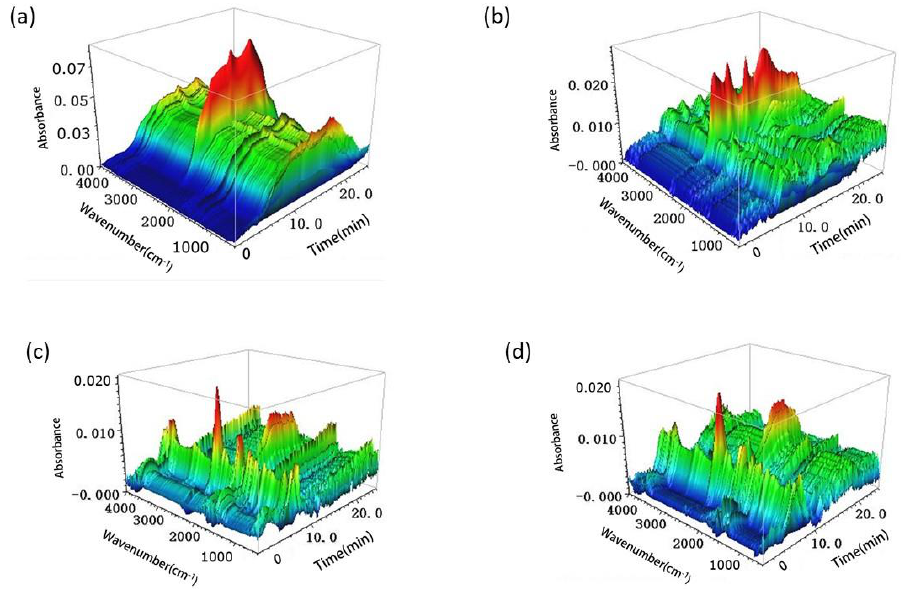
Figure 3. 3D FTIR spectrograms of bark ( a ), bark/Ag ( b ), bark/Co 3 O 4 ( c ), and bark/Ag-Co 3 O 4 ( d ).